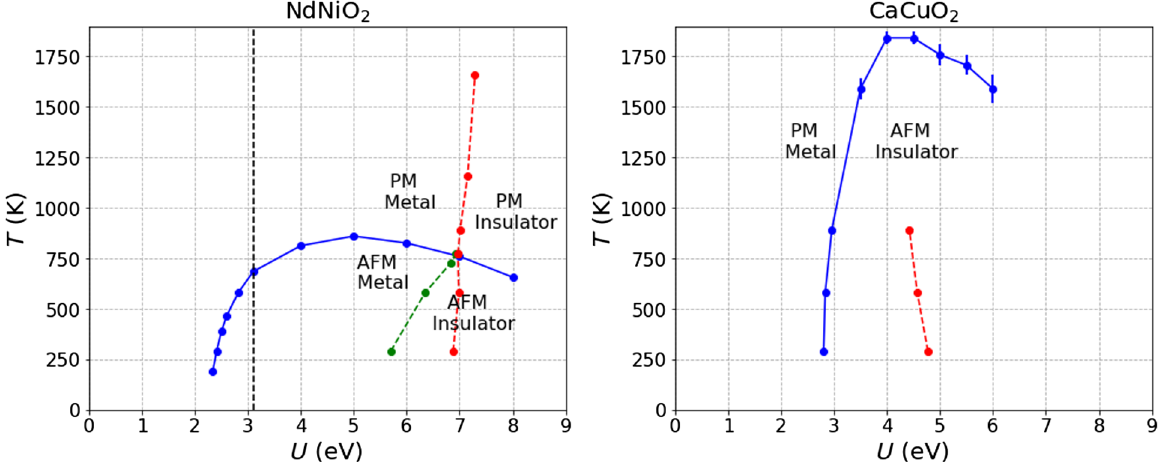
FIG. 5. Phase diagrams of NdNiO 2 (left-hand panel) and CaCuO 2 (right-hand panel) in the plane of temperature T and on-site interaction U , calculated using single-site DMFT with band parameters obtained from a narrow energy window Wannier construction. The solid blue line shows the paramagnetic-antiferromagnetic (PM-AFM) transition. The red dashed lines show the paramagnetic metal to paramagnetic insulator transition, and in the left-hand panel the green dashed line shows the antiferromagnetic metal to antiferromagnetic insulator transition. In the antiferromagnetic regime (temperatures below the blue line) the red dashed line indicates the paramagnetic metal-insulator transition if the antiferromagnetic solution is suppressed. Note that the end points do not correspond to critical points, but show the parameter range in which we have performed calculations. The dashed black vertical line marks the approximate narrow window interaction parameter found in CRPA calculations